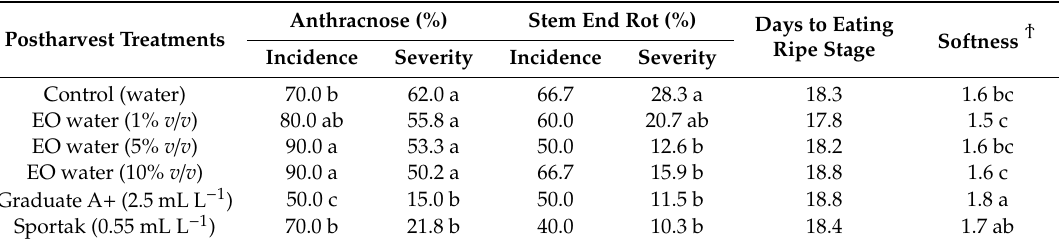
Table 2. E ff ect of electrolyzed oxidizing (EO) water and synthetic fungicides on postharvest diseases and ripening properties of avocado cv. Hass, Trial 1.